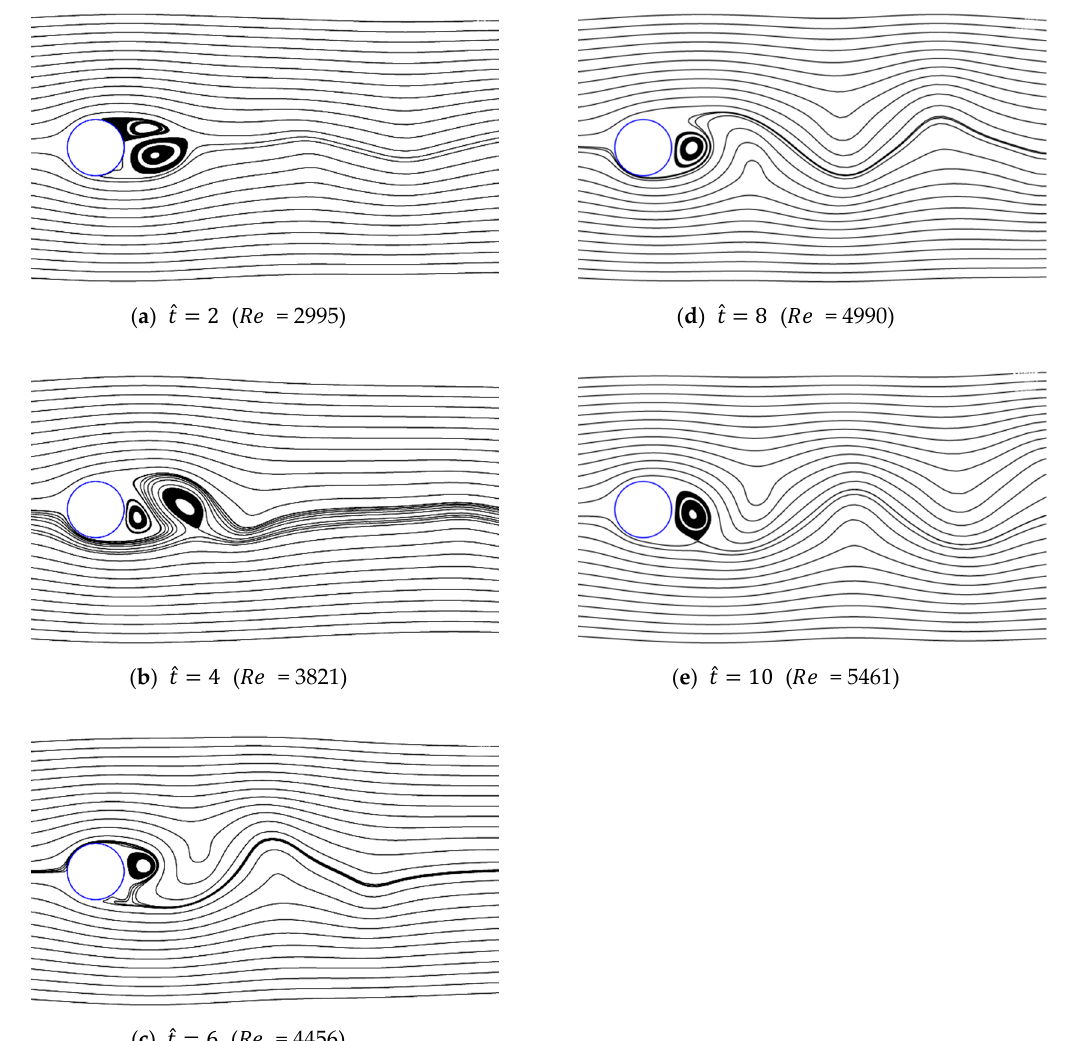
Figure 27. Streamlines around circular cylinder ( a / g = 0.05, Re 0 = 1000 )